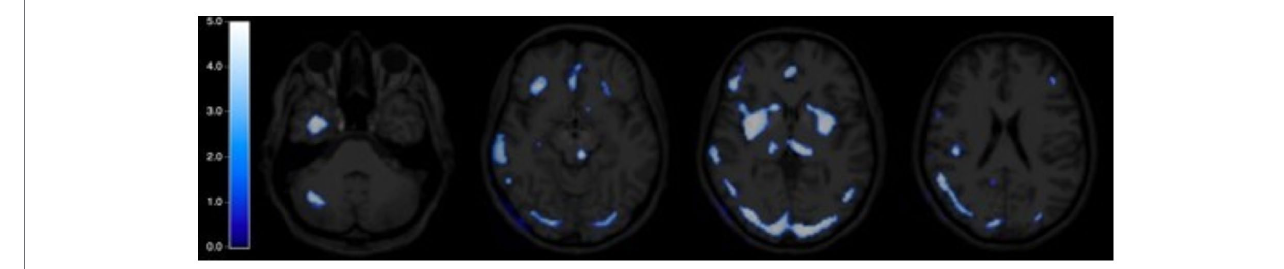
FIGURE 3 | Statistical parametric map of regional cerebral blood flow (rCBF) after DI. Cerebral map expressed in t score of the negative change in rCBF at R0 compared with BDC-4, paired t -test, p uncorr < 0.001, extent threshold > 100 voxels.